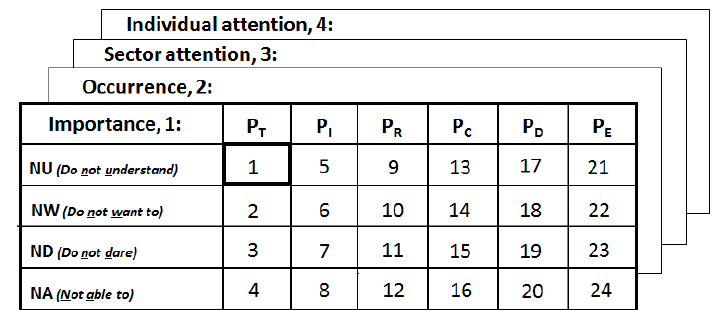
Figure 2 The question generator, relating situational problem components to causes for inadequate performance, including the four aspects (importance, occurrence, sector attention and individual attention).